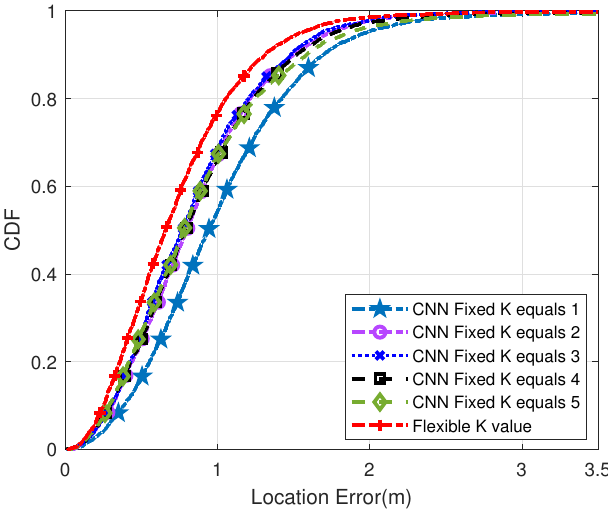
Figure 9. Probability distribution diagram of positioning error when the distance between two reference points is 2 m (Q = 200).